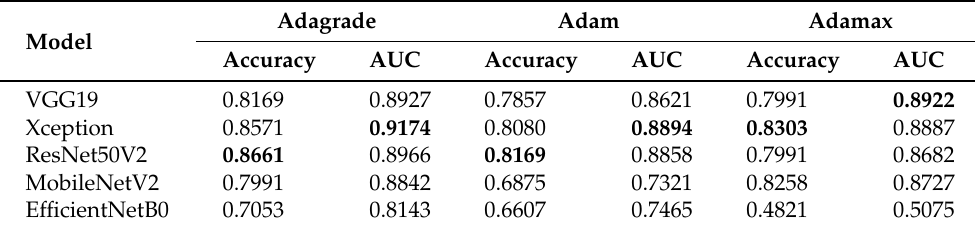
Table 3. Model performance for different